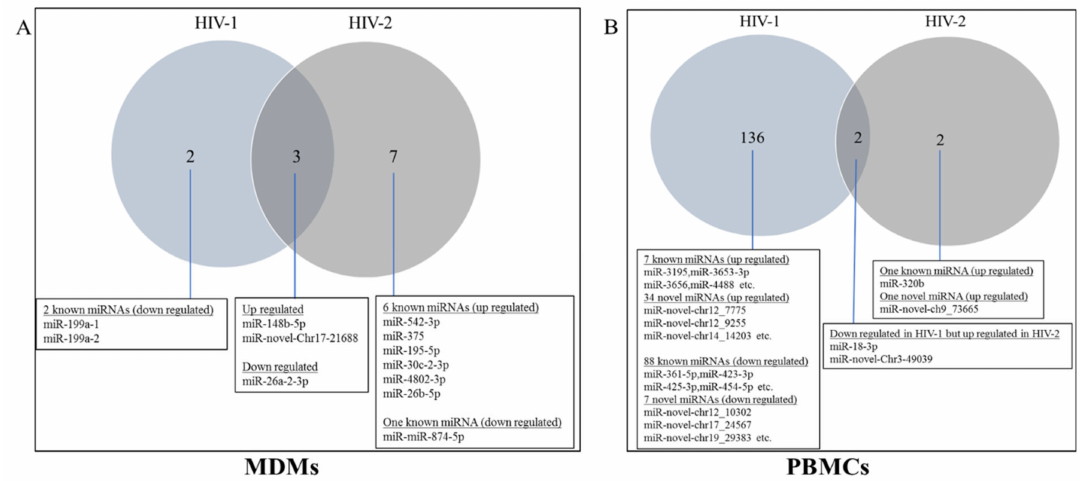
Figure4. Analysisofcommonanduniquedi ff erentiallyexpressedmiRNAsinHIV-1-andHIV-2-infected MDMs and PBMCs. Venn diagrams indicate the number of overlapping and non-overlapping di ff erentially regulated miRNAs in MDMs ( A ) and PBMCs ( B ) infected with HIV-1 and HIV-2 compared to uninfected control MDMs and PBMCs.